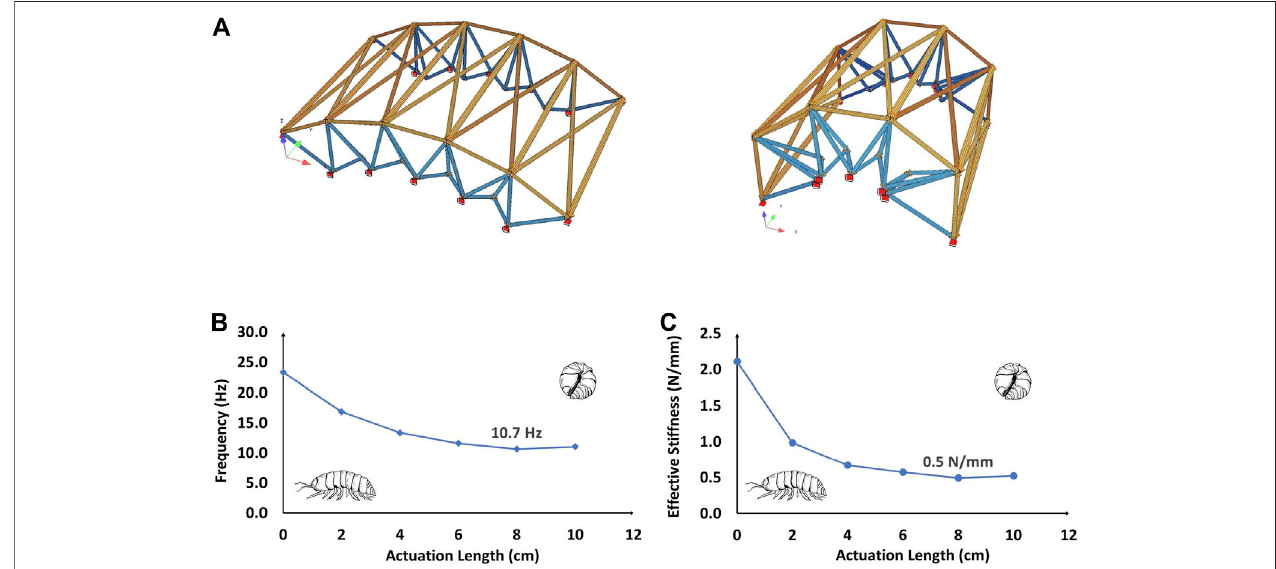
FIGURE 6 | (A) Finite element model for the 5-module OPB structure from SOFiSTiK (2020) in both unrolled and rolled con fi guration. (B) The plot shows the frequenciesofthe fi rststructuralmodeatdifferentstagesofrolling.FirstmodalfrequencyoftheOPBstructuredecreasesthroughrollingreachingaminimumof10.7 Hz. (C) Theplotshowstheeffectivestiffnessofthestructurebasedonits fi rststructuralmodefrequencies.Effectivestiffnessofthestructuredecreasesoveractuationwitha minimum value of 0.5 N/mm.